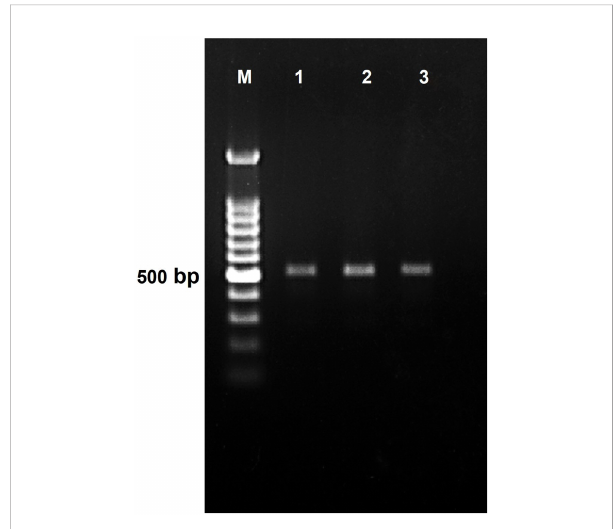
FIGURE 4 PCR ampli fi cation product generated using LRGAF and LRGAR degenerate primer on genomic DNA of lentil resistant accession. Lane 1 IC201561 (L65), Lane 2 EC714243 (L83), and Lane 3 EC718238 (L90). M represents 100 bp